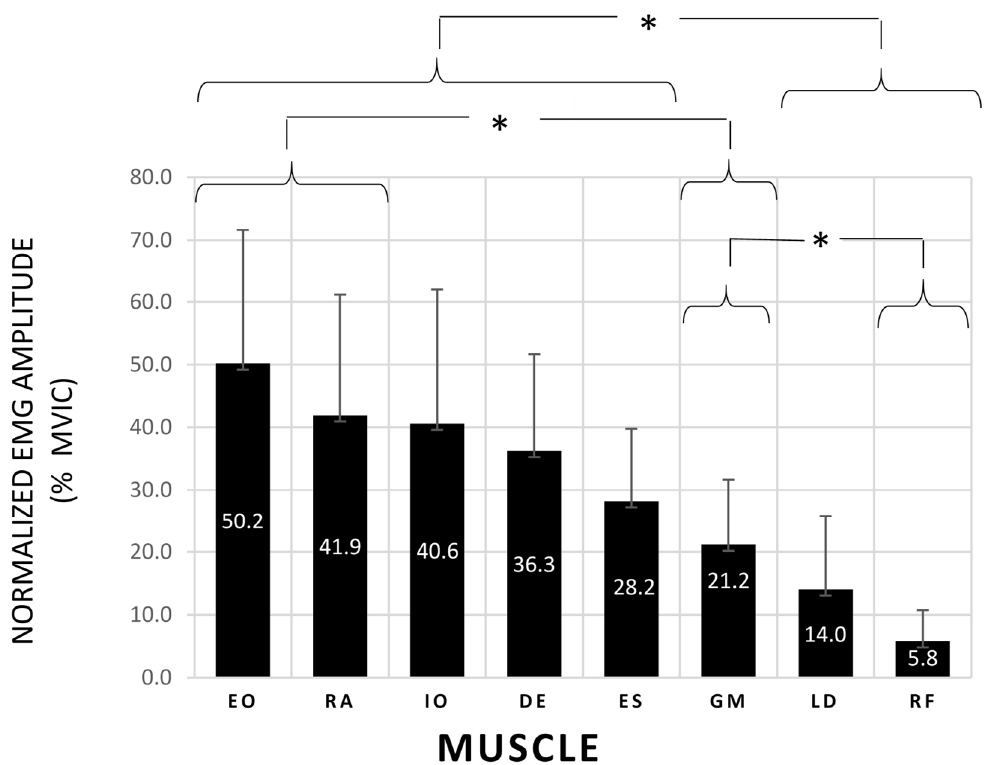
Figure 2. Normalized EMG amplitude obtained during the side bridge test for the following muscles: